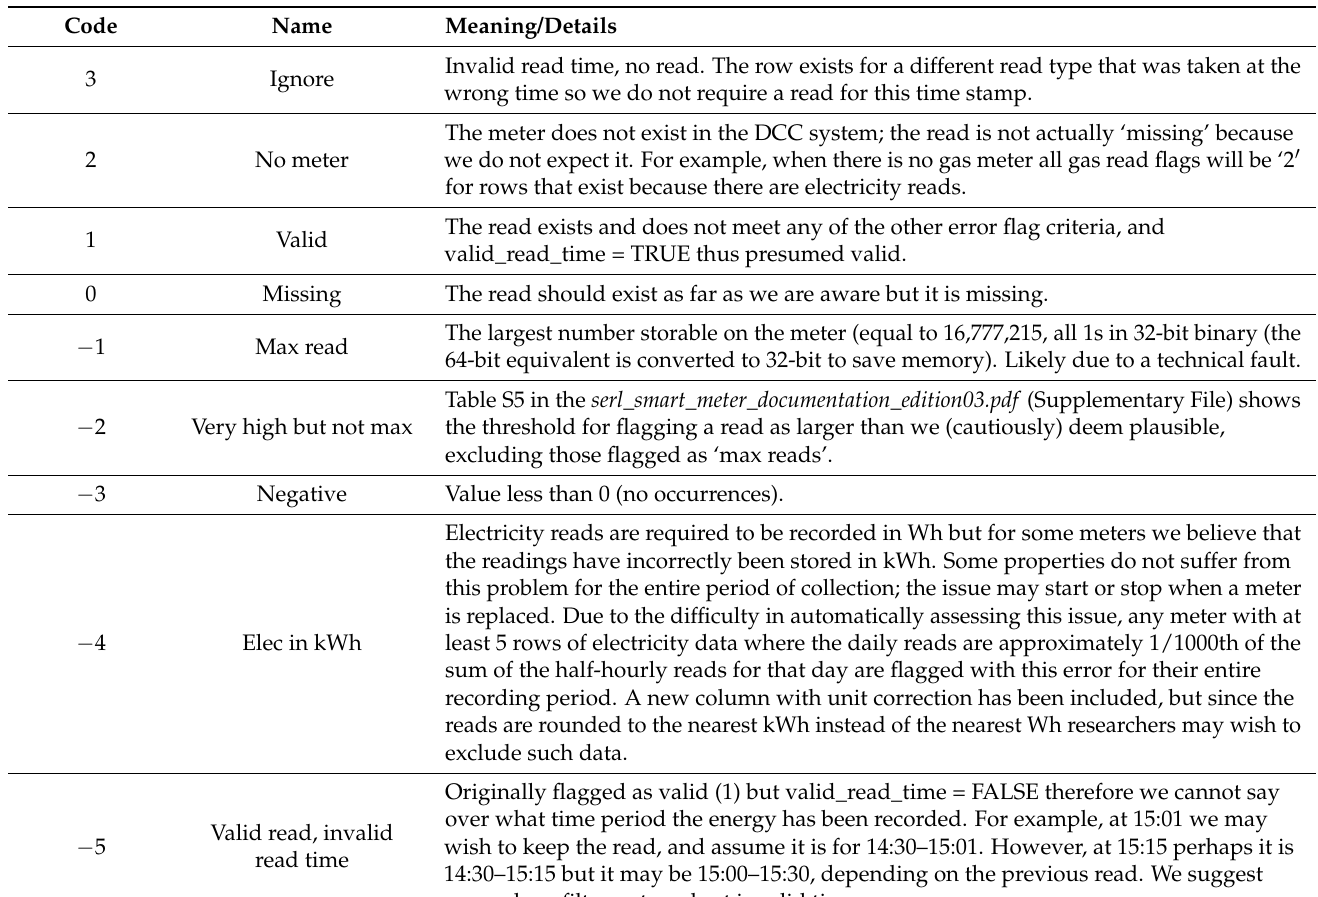
Table 3. Error flags and their